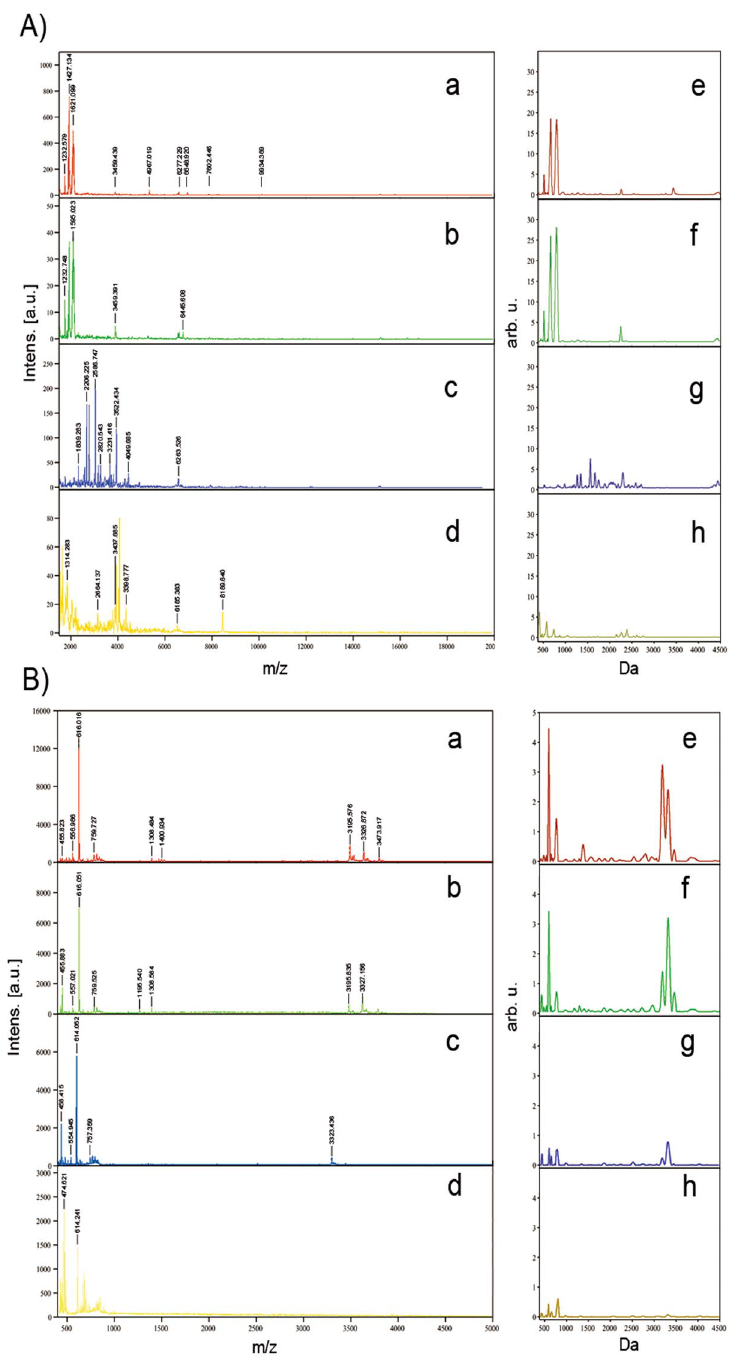
Figure 3. (a–d) Representative mass spectrum at (a) 0, (b) 48, (c) 96, and (d) 144 h postmortem for liver tissues. (e–h) Average peptide/protein profiles at (e) 0, (f) 48, (g) 96, and (h) 144 h postmortem for liver tissues. ( A ) In SD rat liver samples; ( B ) in human liver